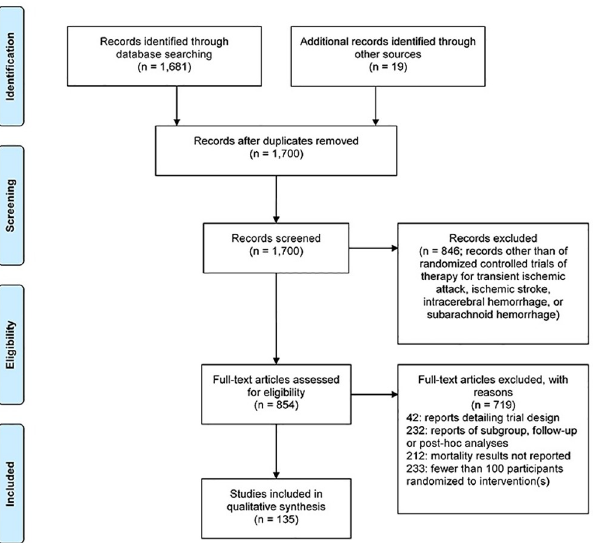
Fig 1. PRISMA flowchart regarding the search, screening, and selection of the identified articles.